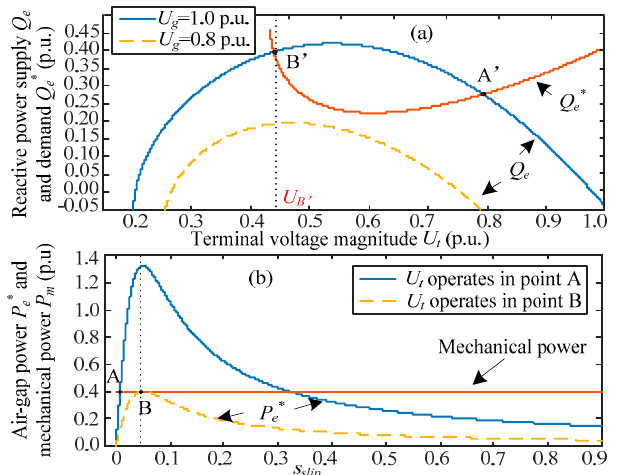
Figure 11. IM stalling analysis: ( a ) reactive power supply Q e and reactive power demand Q e * versus terminal voltage magnitude U t curves; ( b ) air-gap power P e * and mechanical power P m versus slip curves.